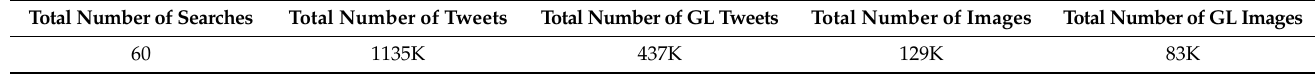
Table 1. General overview of results obtained by testing the system with 60 searches.